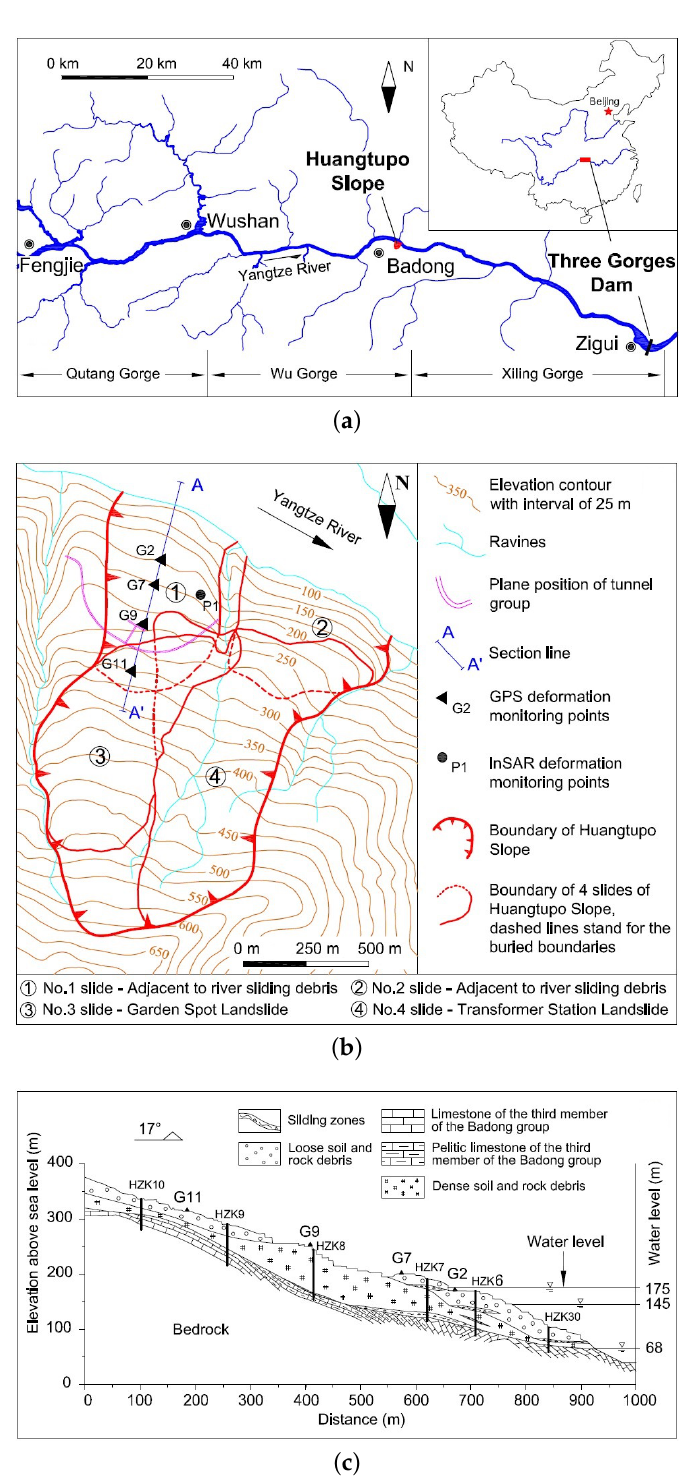
Figure 1. ( a ) Location of the Three Gorges project and the Huangtupo landslide; ( b ) Map showing the four distinct landslides; ( c ) Cross section along A–A’ through the No. 1 slide (Wang et al. [15]). The survey report in [21] indicates that the Huangtupo landslide is a large and complex landslide with multiple sliding times and sliding zones. Because the No. 1 and the No. 2 slides are adjacent to the Three Gorges reservoir, their stability is significantly affected by the fluctuation of the water level in the reservoir. This study focuses on the No. 1 slide. The field investigation indicates that the No.